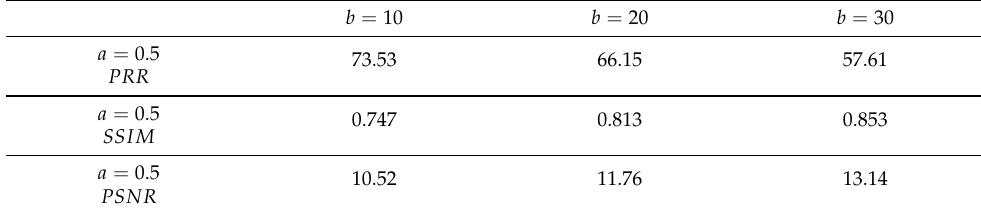
Table 7. Car image without HE for a = 0.5.